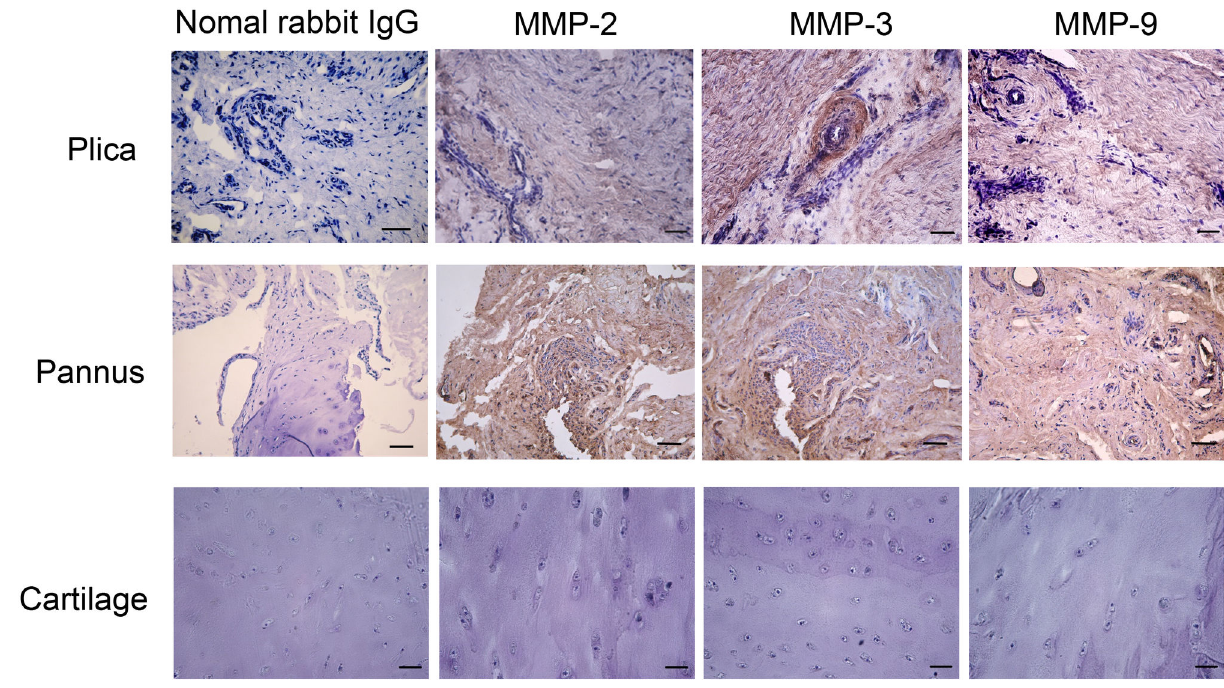
Figure 3. Immunohistochemical staining for MMP-2, MMP-3, or MMP-9 in the medial plica and pannus tissue of stage IV OA patients and normal cartilage. The panels on the left are negative controls using normal rabbit IgG instead of primary antibody. The bars represent 10 μm. The results are typical of those seen for all 18 OA knees.